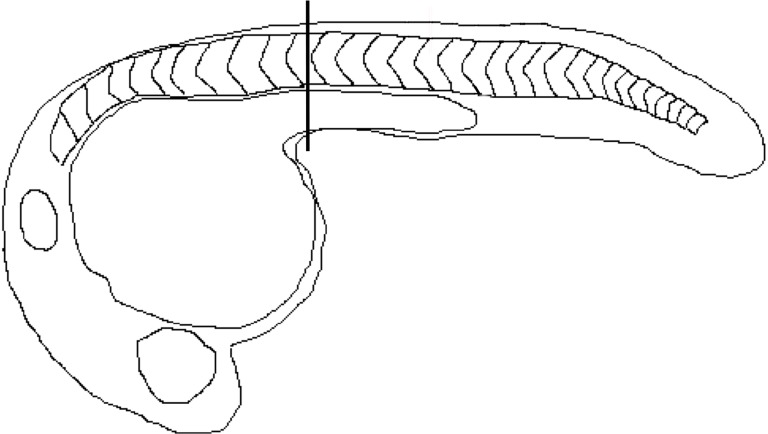
Zebrafish embryo.Several sections of 85 nm thickness were obtained from the area posterior to the yolk ball, within the yolk extension as indicated by the vertical line.